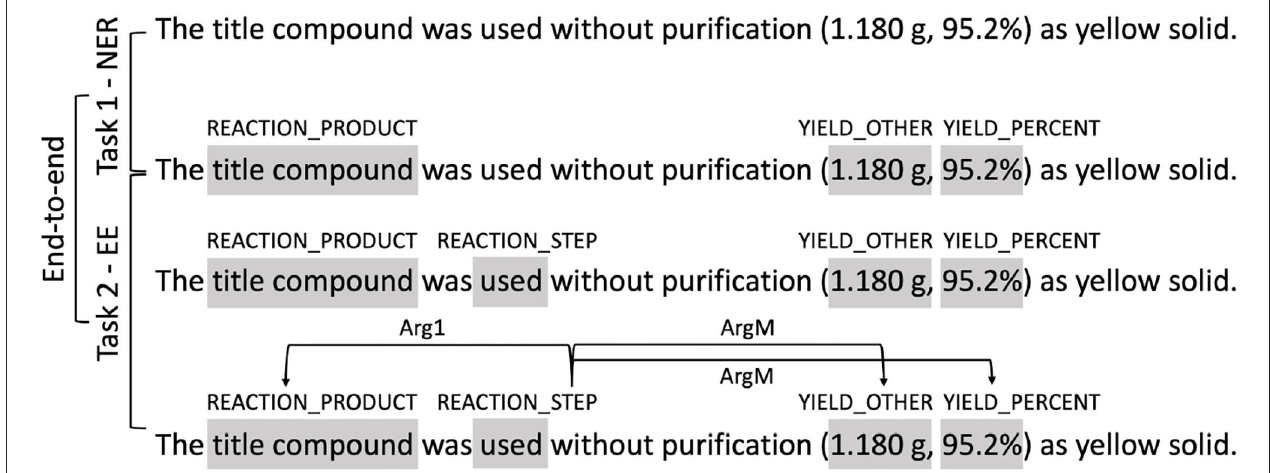
FIGURE 6 | Illustration of the three tasks. Shaded text spans represent annotated entities or trigger words. Arrows represent relations between